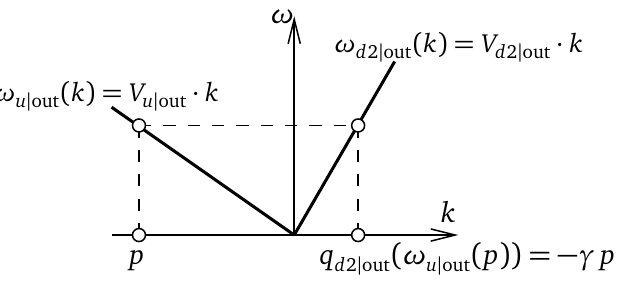
Figure 10: Dispersion relations in the long wavelength (dispersionless) limit. = V − c ( < 0 ) , V = V + c V and γ ≡ − V u | out u u d 2 | out d d